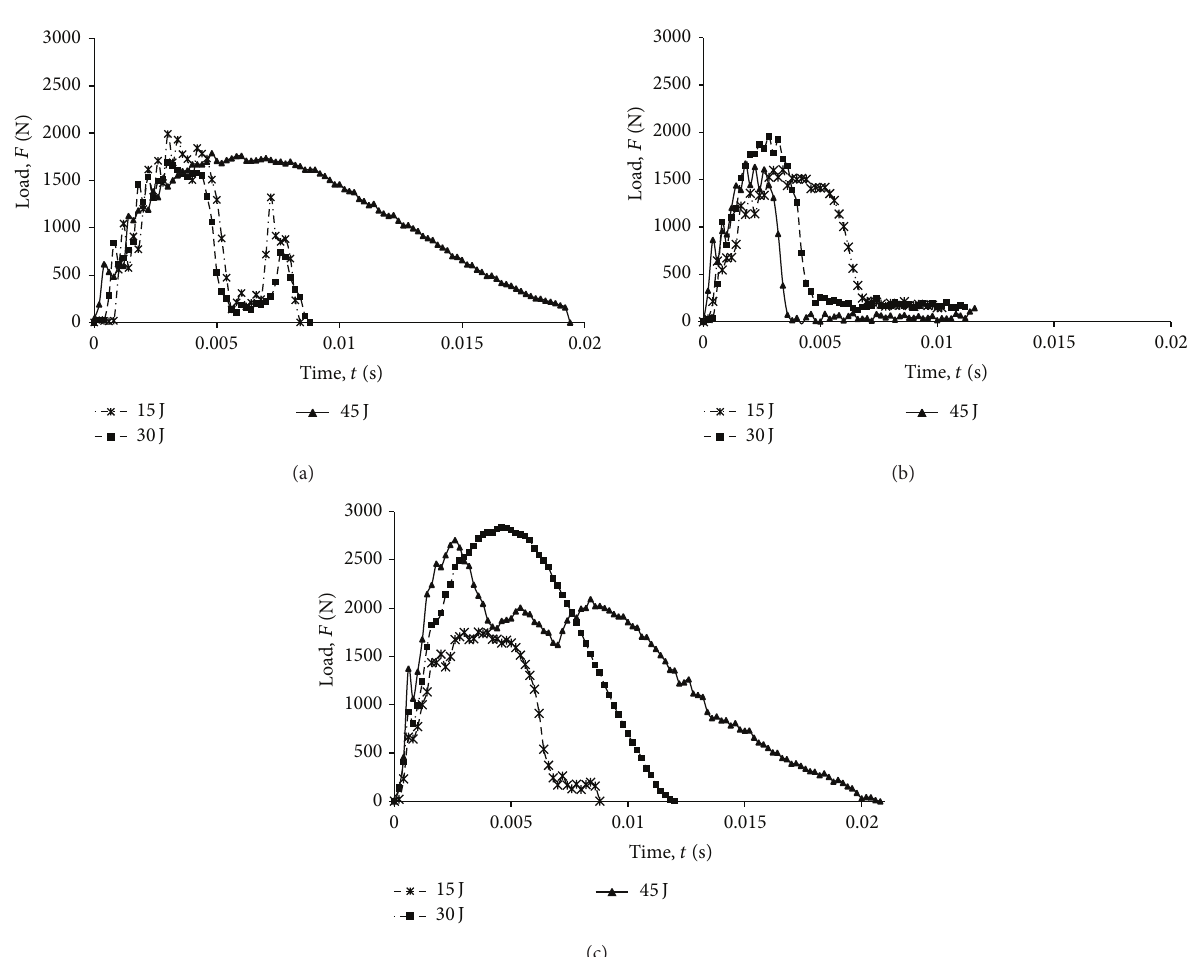
Figure 4: Load versus time plots for sandwich panels with different thicknesses (a) 20mm, (b) 40 mm, and (c) 60 mm subjected to different impact